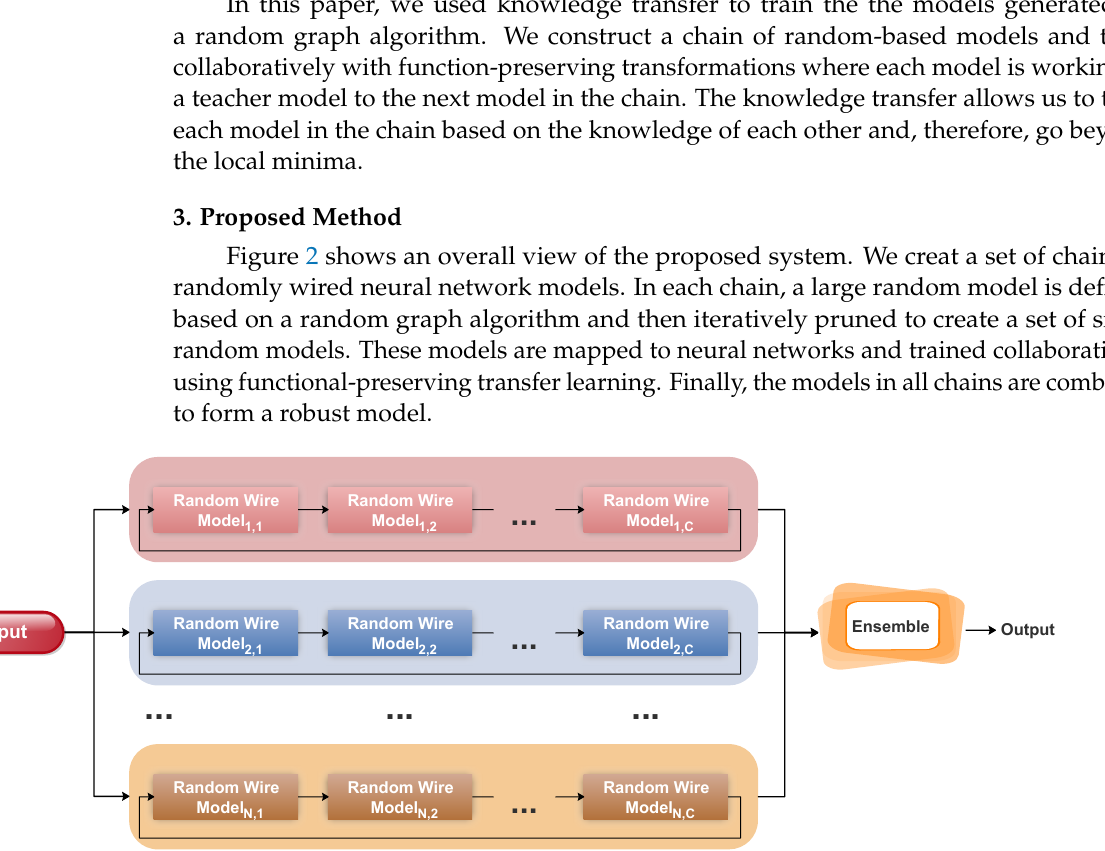
Figure 2. The proposed system overview. First, multiple sets of a chain of randomly wired models are created. These models are mapped to neural networks and trained collaboratively using functional-preserving transfer learning. Finally, the models in all chains are combined to form a robust ensemble